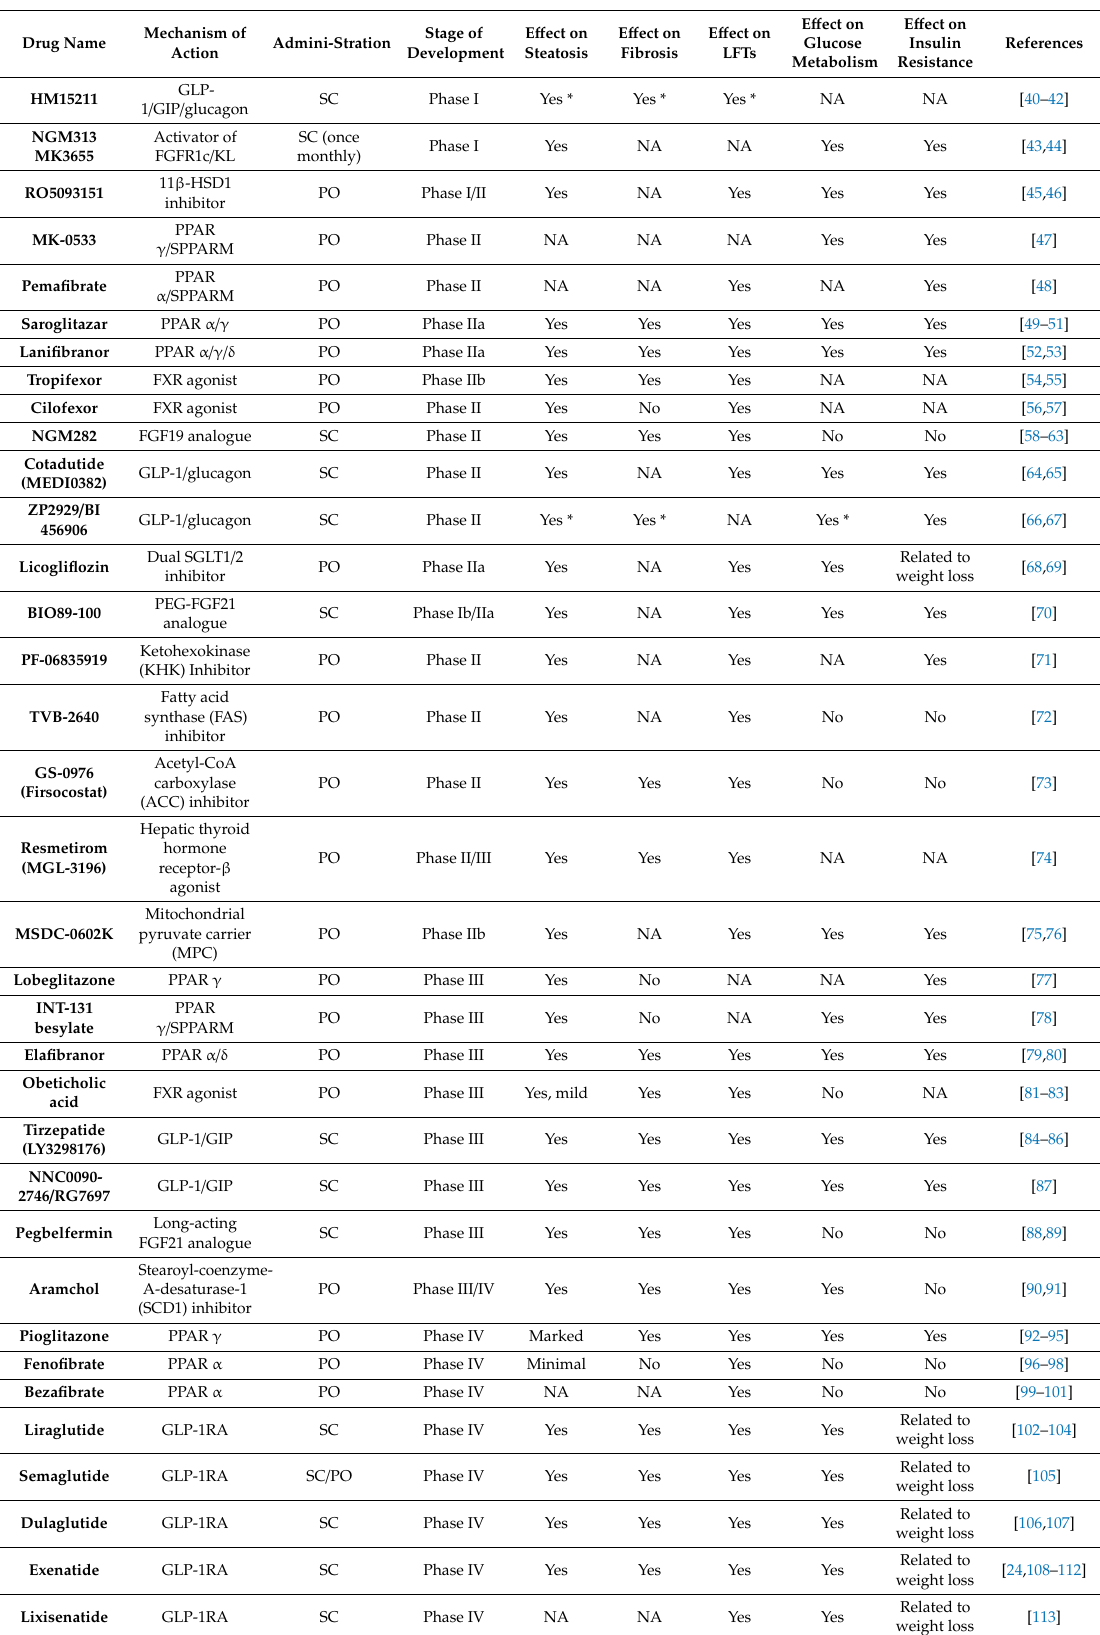
Table 1. Drugs with known e ff ect on parameters of NAFLD / NASH (divided by the clinical trial phase). Drug